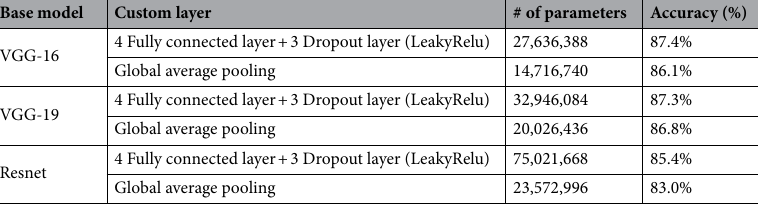
Table 2. Comparative results of our deep learning models (VGG-16, VGG-19 and Resnet based Model).